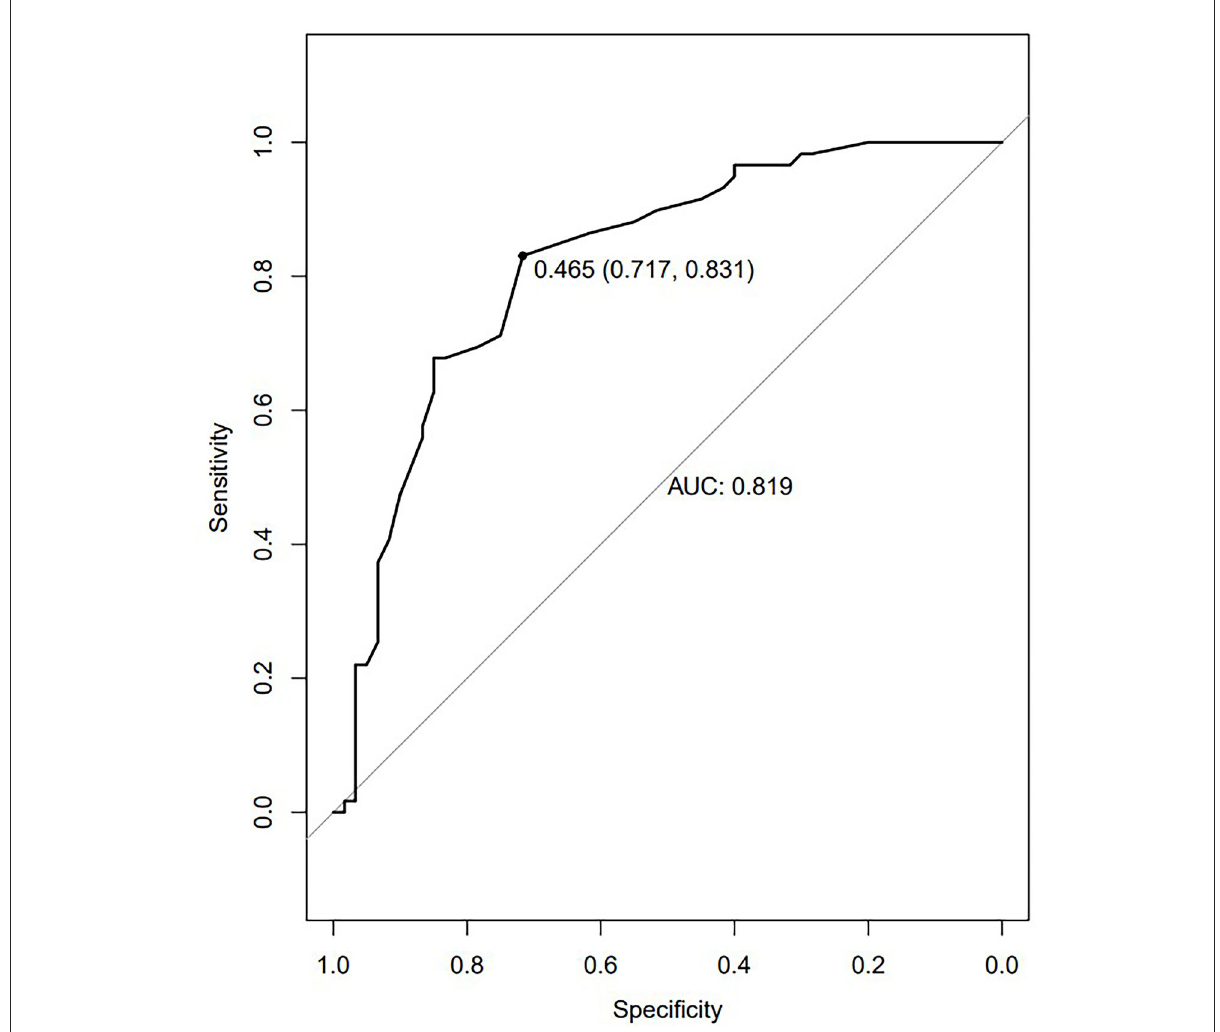
FIGURE2 The ROC curves of the altered brain regions in the diagnosis of TLE. The ROC curve of MTG VMHC values. The AUC was 0.819. The optimum cutoff value was 0.465 (sensitivity: 0.831 and specificity: